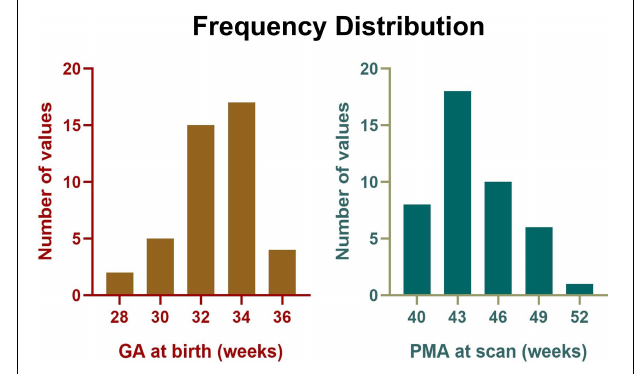
FIGURE 2 | Frequency distribution of GA at birth and PMA at scan for all